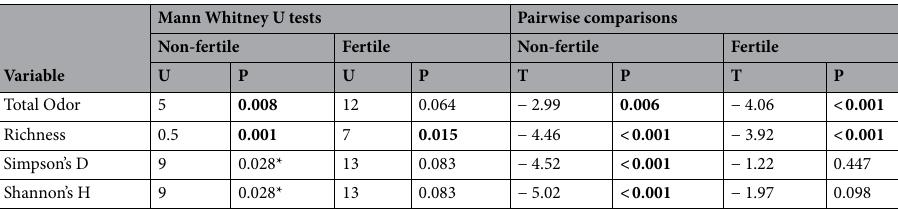
Table 3. Evaluation of the differences between MF and FF subjects. Results from Mann Whitney U tests (all tests were conducted on 7 MF cycles and 8 FF cycles**) and pairwise comparisons (tests conducted on the whole datasets after having fitted GLMMs using two categories for individual cycle**). Bolded p-values are significant. *Not significant after a Bonferroni correction (adjusted alpha < 0.025). **For results using one cycle per female or four categories for individual cycle, see Supplementary Table